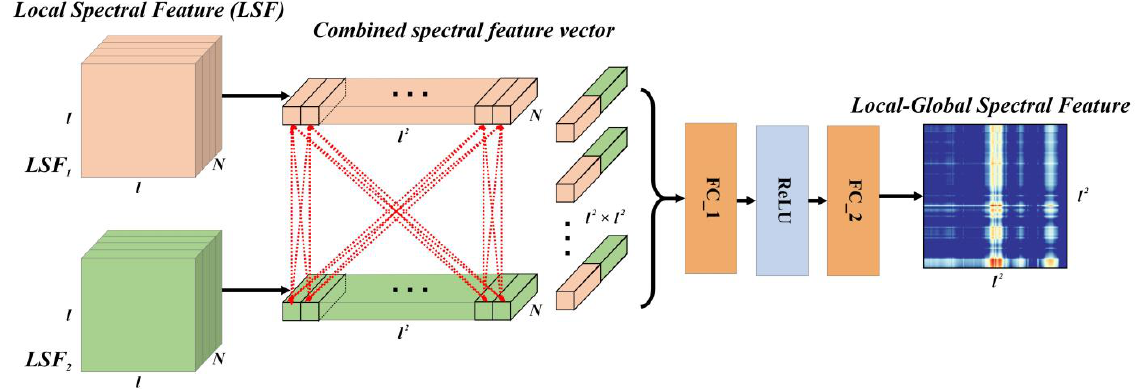
Figure 4. GSFEM architecture. The input to the GSFEM is represented by two LSF groups, while the output is the LGSF.